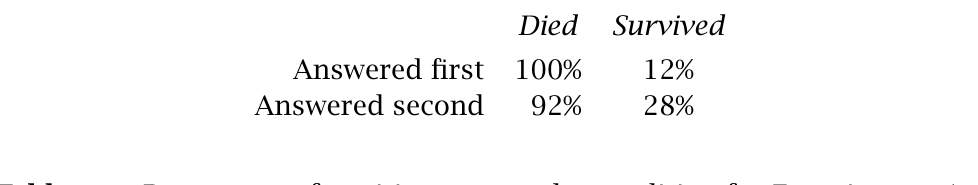
Percentage of positive answers by condition for Experiment 1